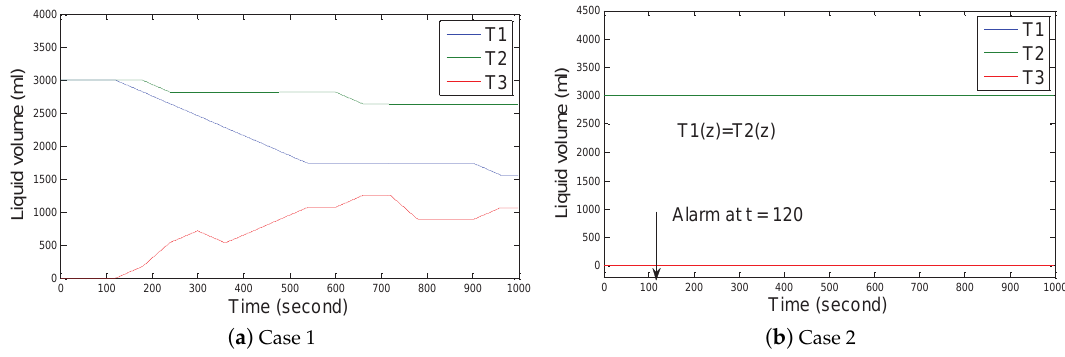
Figure 8. The real values of sensors under false sequence < P 1 f , P 1 o > .